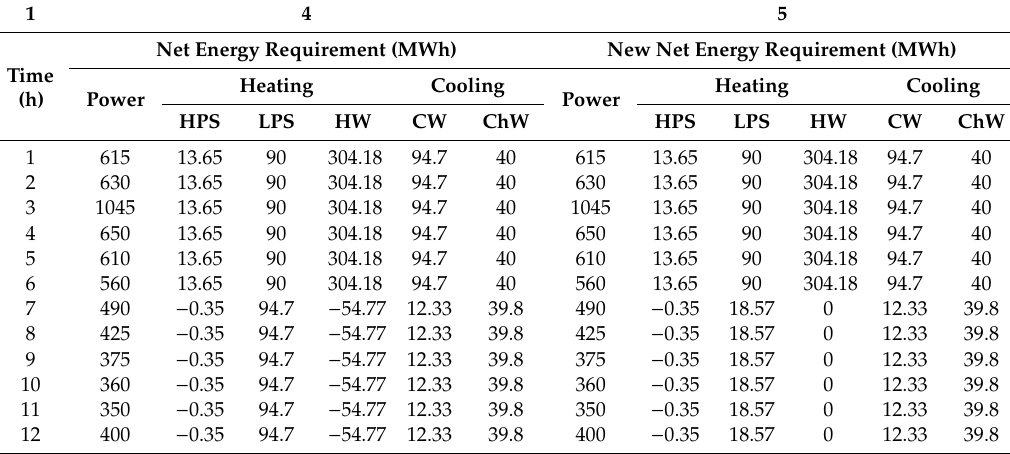
Table A3. TriGenSCA before iteration from time 1 to 12